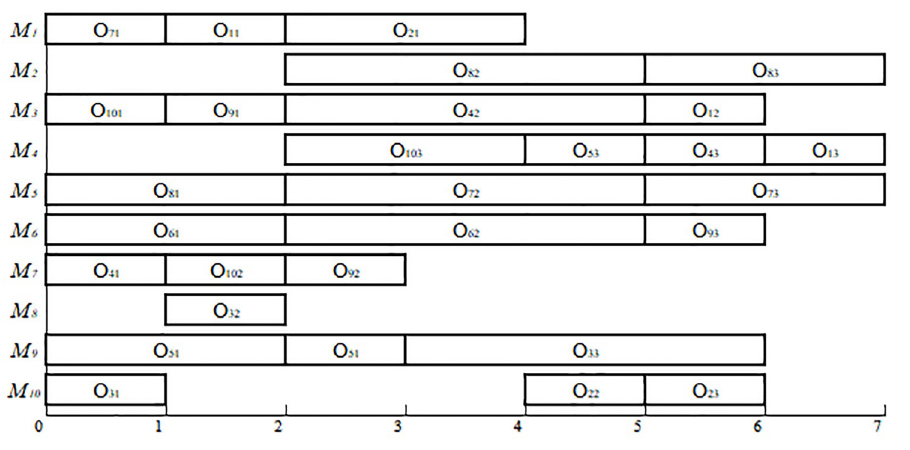
Fig 6. Gantt chart of the 10 × 10 FJSP